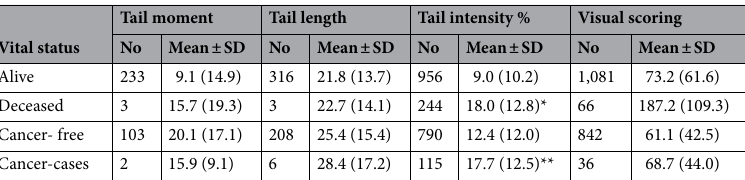
Table 2. Comparison of subjects diagnosed with cancer, deceased for any cause, and alive according to mean DNA damage level measured by the main descriptors of the comet assay. The hCOMET cohort. To ensure comparability, t-test was performed on standardized measures at laboratory and study level; * P < 0.001 (vs alive);** P = 0.017 (vs cancer free